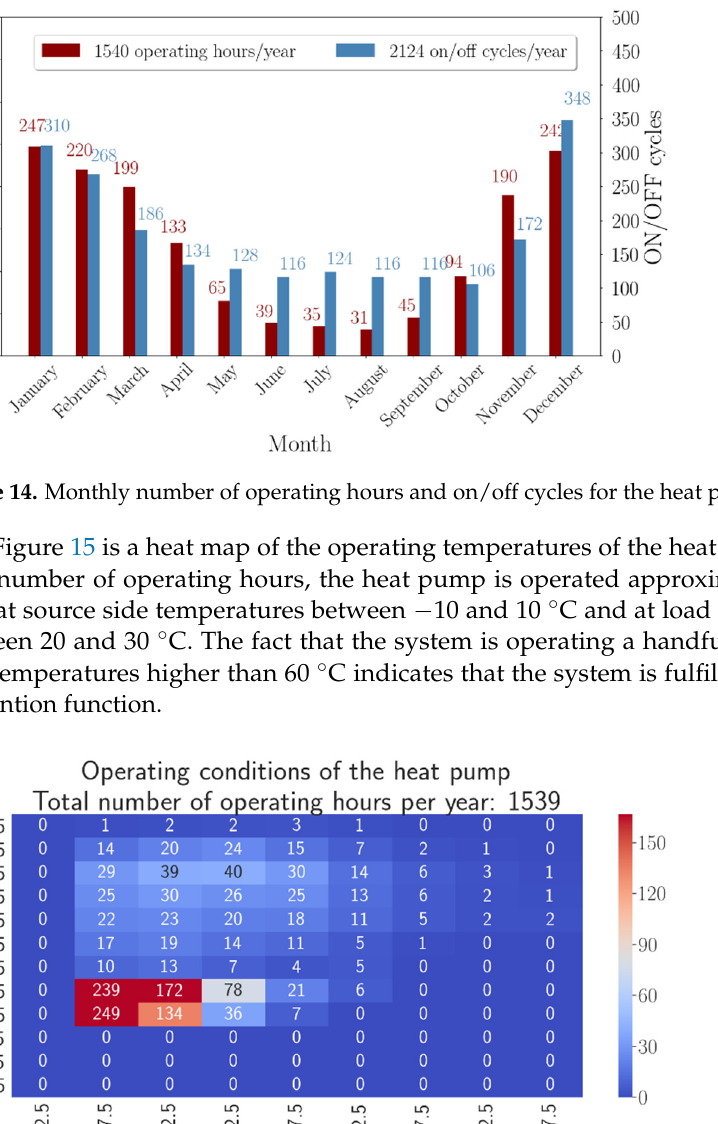
19 of 30 Figure 13. Monthly working envelope control signals of the heat pump.